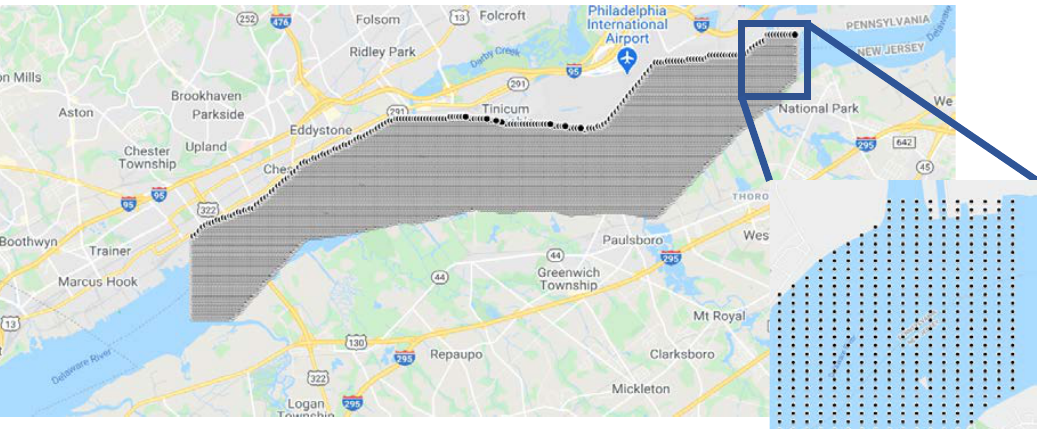
Figure 1. Definition of a grid consistent with river boundaries using the Earth topography 5 arc minute (ETOPO5) database in the Delaware River. The grid is a standard orthogonal grid, except along the boundaries. Map created with Google MyMaps.